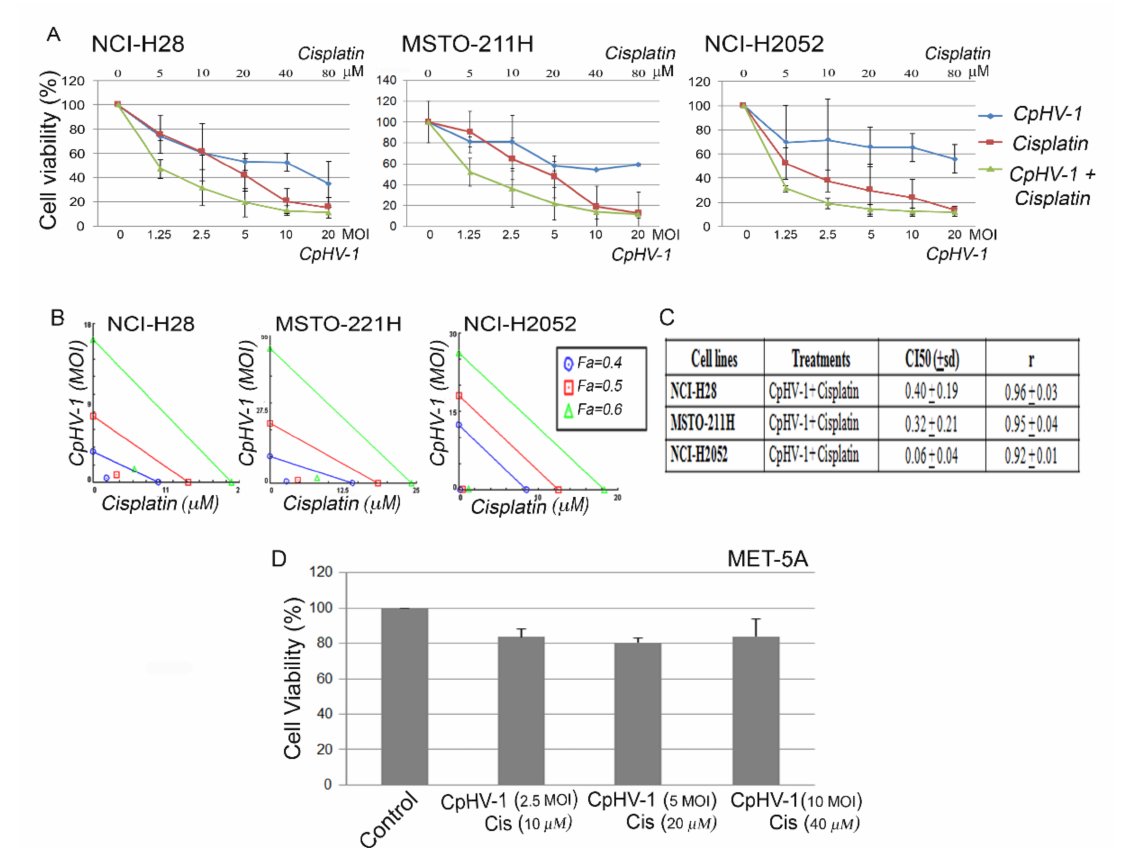
Figure 4. Synergistic effect of caprine herpesvirus 1 (CpHV-1) and cisplatin in mesothelioma cell lines. ( A ) Dose-response curves of CpHV-1 alone, cisplatin alone, and both agents in combination in NCI-H28, MSTO-211H, and NCI-H2052 mesothelioma cell lines 72 h after treatment. Results represent the means ± standard deviation of two independent experiments, each conducted in triplicate, and are expressed as percentages of cell viability calculated with respect to control cells treated with DMSO alone. ( B ) Isobologram analysis to assess synergism between CpHV-1 and cisplatin. Isobolograms are derived from the mean values of the dose–response experiments reported in A, through the Compusyn software at fixed effect levels (Fa, fraction affected) of 40%, 50%, and 60%. The points below the lines indicate synergism. ( C ) Table reporting the means ± standard deviations of combination index (CI) and the r values of the CpHV-1 and cisplatin combination at 50% of cell killing (CI50) following 72 h of treatment, calculated using Compusyn software for each of the two independent experiments. CI values < 1 indicate synergism. ( D ) Histogram showing that 72 h of treatment with CpHV-1 and cisplatin in combination at the indicated doses had no significant toxic effect on the normal mesothelial cells MET-5A, as assessed through MTS and evaluated by one-way repeated measures ANOVA with Bonferroni post-test. Results are reported as means ± standard deviations of two independent experiments and expressed as percentages of cell viability relative to control cells treated with DMSO